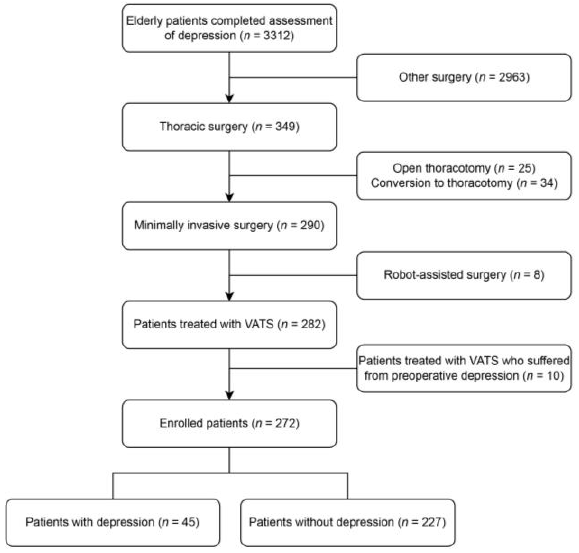
Figure 1. Details on study recruitment.